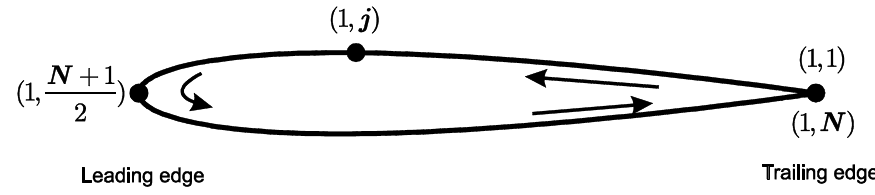
Figure 1. The node definition on the airfoil surface.